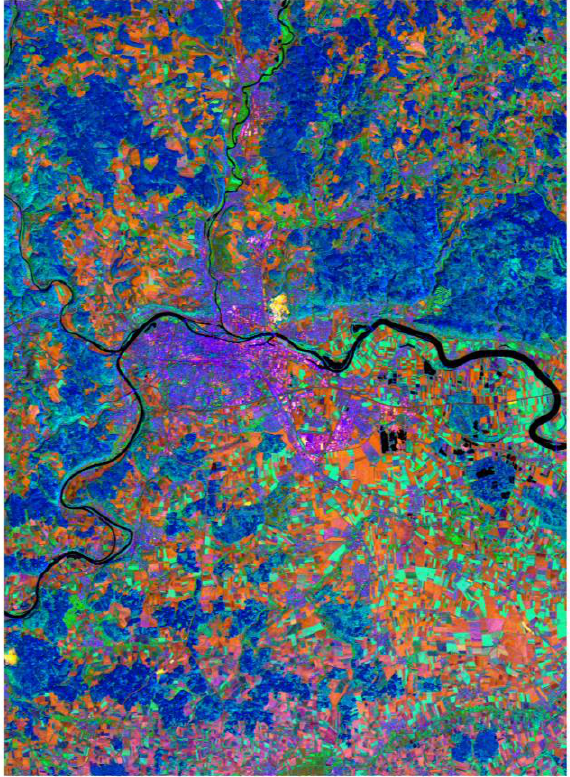
Figure 8. RGB composite of Sentinel-2 (RED), Sentinel-2 (NIR), Sentinel-1a (VH). The Sentinel-2 image is from 16 Mar. 2016 and Sentinel-1a image is from 20 Jul. 2015. Urban areas are seen in pink- violet, Agriculture in orange-light green, Forests in light blue-dark blue and water in black. Man-made open pits are clearly visible in